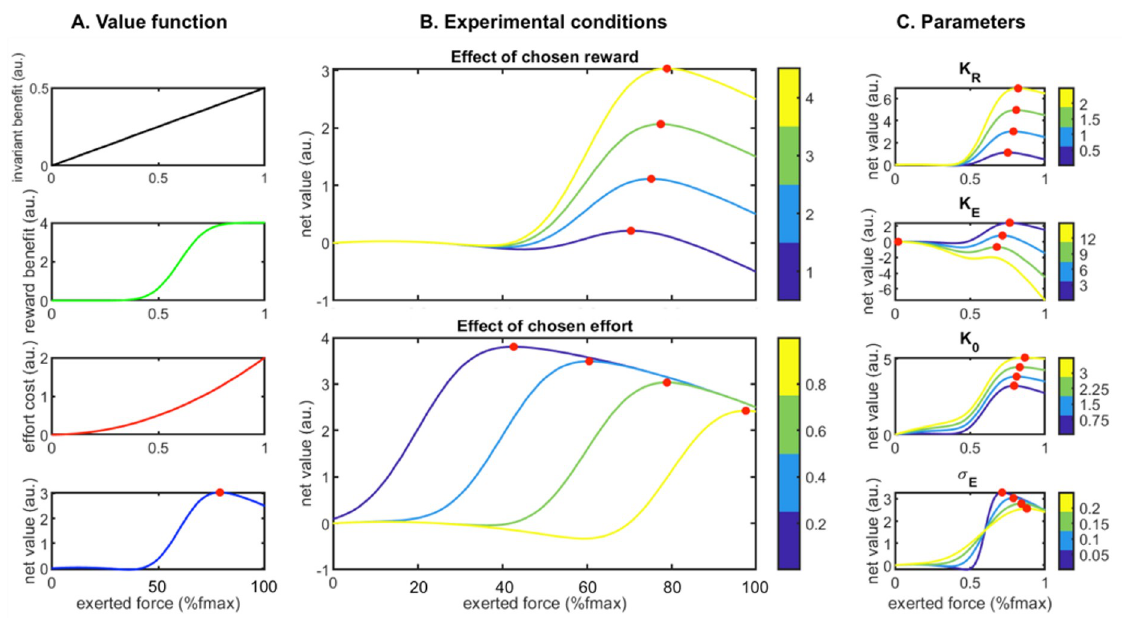
Fig 3. Properties of the optimal force selection model. A . Components of the value function depending on the exerted force. A1 : the activation component is a linear invariant benefit, A2 : the reward benefit component is a sigmoidal function with a slope scaled by the uncertainty component, A3 : the effort cost component is a quadratic function. A4 : The net value is the sum of 3 previously described components. B . Impact of main experimental conditions onto the value function: B1 : chosen rewards increase the optimal expected value and slightly shift the optimal force. B2 : chosen effort decreases the optimal expected value but increases the optimal force (bottom) C . Impact of main parameters onto the value function. C1 : increase of K r (sensitivity to reward) leads to huge increase of optimal value and slight increase of optimal force. C2 : increase of K e (sensitivity to effort) leads to decrease of optimal value and decrease of optimal force with a collapse to zero-force when the optimal value becomes negative. C3 : increase of K o (activation weight) leads to increase of optimal value and increase of optimal force. C4 : increase of σ E: ( action-outcome uncertainty ) leads to decrease of optimal value and increase of optimal force, shifting it away from the target force (bottom). Simulations were performed with an initial parameters vector of {= 1; = − 1; = 2; = 1; = 0.5; = − 1; = 0.1; = 0; = 0; = 0} and an initial input vector of {R = 4; E = 0.6; N = 0}. Red dots indicate the optimal force to exert when the net value function is represented. Color-bars indicate either input or parameter values when there are variations. au., arbitrary units; Fmax: maximal